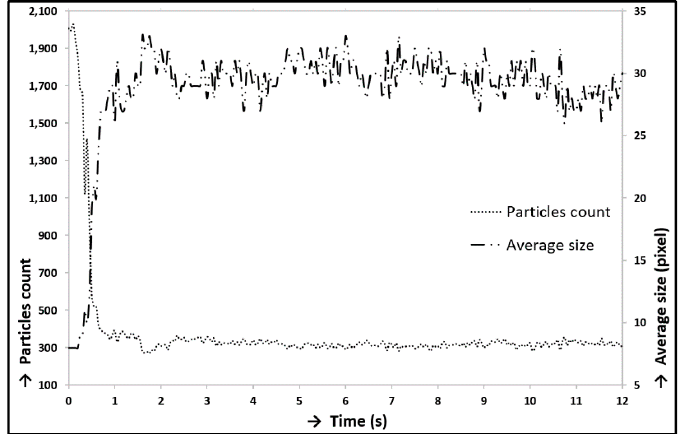
Materials 2020 , 13 , 2075 Figure 13 Loading of contact–particles count/average size. Figure 13. Loading of contact–particles count / average size. Figure 13 Loading of contact–particles count/average size.